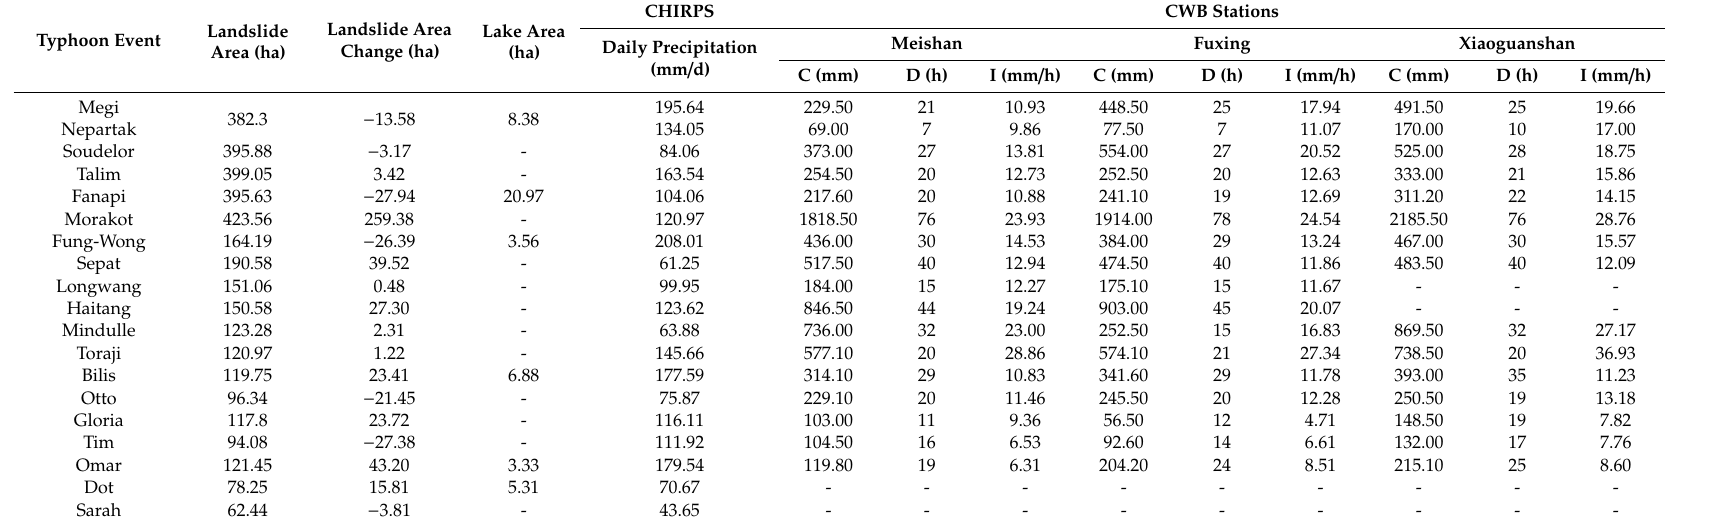
Note: C = Cumulative rainfall, D = Duration, I = Mean